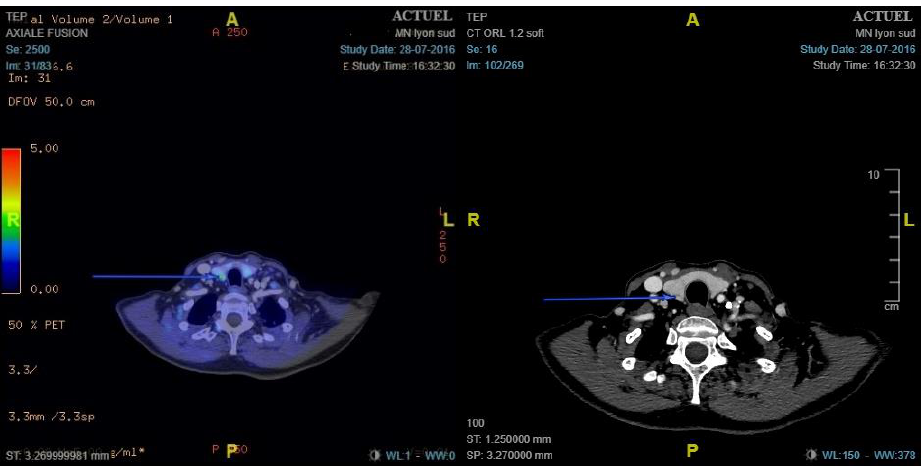
Figure 2. Example of false positive left paraoesophageal lymph node fixing 18 F-choline. 18 F-choline positron emission tomography/contrast-enhanced computed tomography shows left latero-oesophageal nodular hypermetabolism (maximum standardised uptake value, 6.41). Pathology showed a lymph node 1 cm in size.